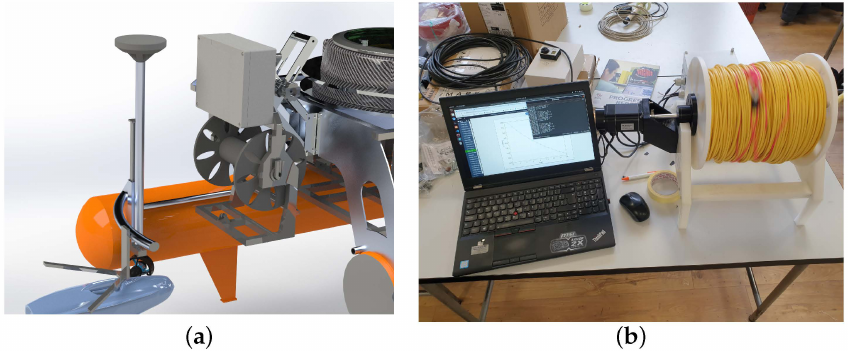
Figure 15. ( a ) SolidWorks model of the tether management system and docking station for the ROV aboard the ASV Korkyra. Side view of the assembly on the ASV. ( b ) Laboratory testing of the prototype TMS.